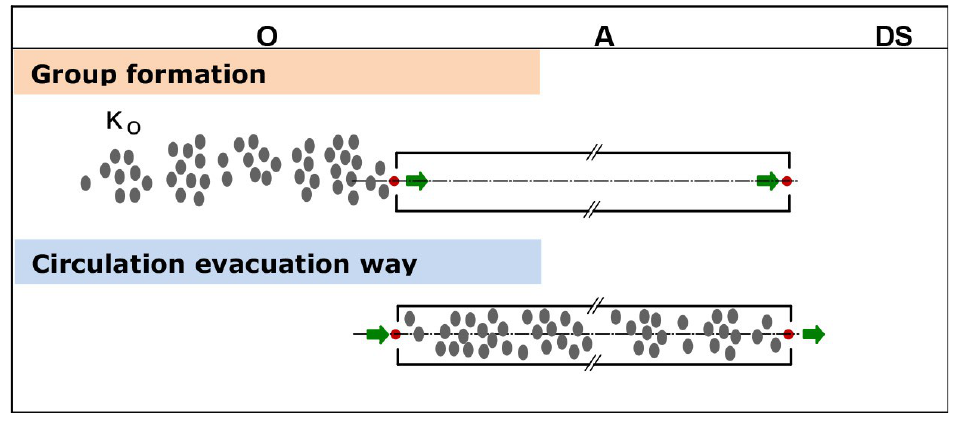
Figure 5. Initial formation of groups in the evacuation process of a single